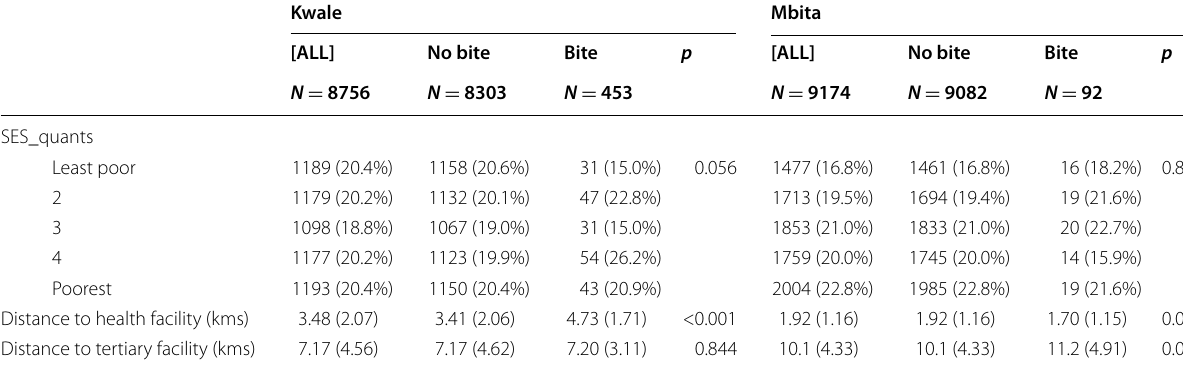
Table 1 Descriptive table of household-level determinants of snakebites to illustrate differences in association of SES and snakebites and access to health care resources by region